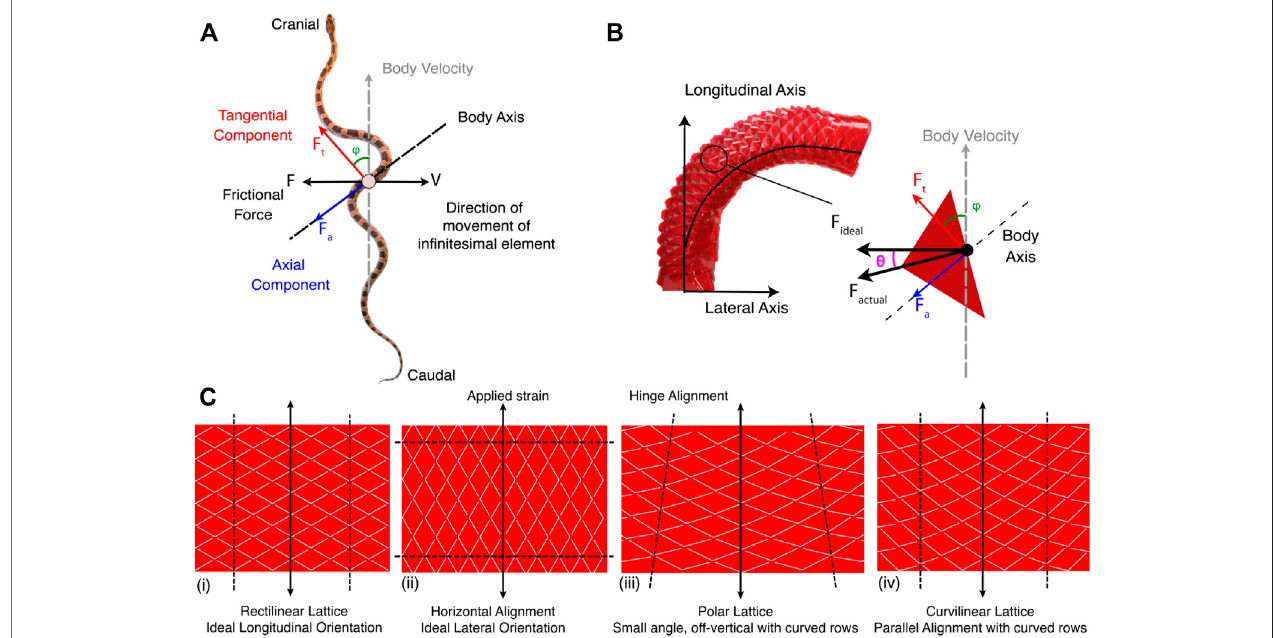
FIGURE 1 | (A) Free body diagram of an in fi nitesimal element of a snake body during lateral undulation (Calisti et al., 2017). (Corn snake pictured (Backwater ReptilesBlog,2020)). (B) Freebodydiagramofascaleonabendingactuator. (C) Latticepatternsforvariousscaleorientationstrategies:(i)isastandardkirigamipattern thatstretcheslongitudinallybutdoesnotbend,andwasusedtoletsoftactuatorscrawl(Rafsanjanietal.,2018),(ii)thesamestandardpatternideallywillnotstretchinthe lateralorientation,(iii)thepolarlatticeproposedinthispaperallowsforbendingbutthescalesizeschangealongthelengthofthebody,and(iv)thecurvilinearlattice proposed in this paper allows for bending and has longitudinally-invariant scales, but is limited to smaller angles of in-plane rotation.